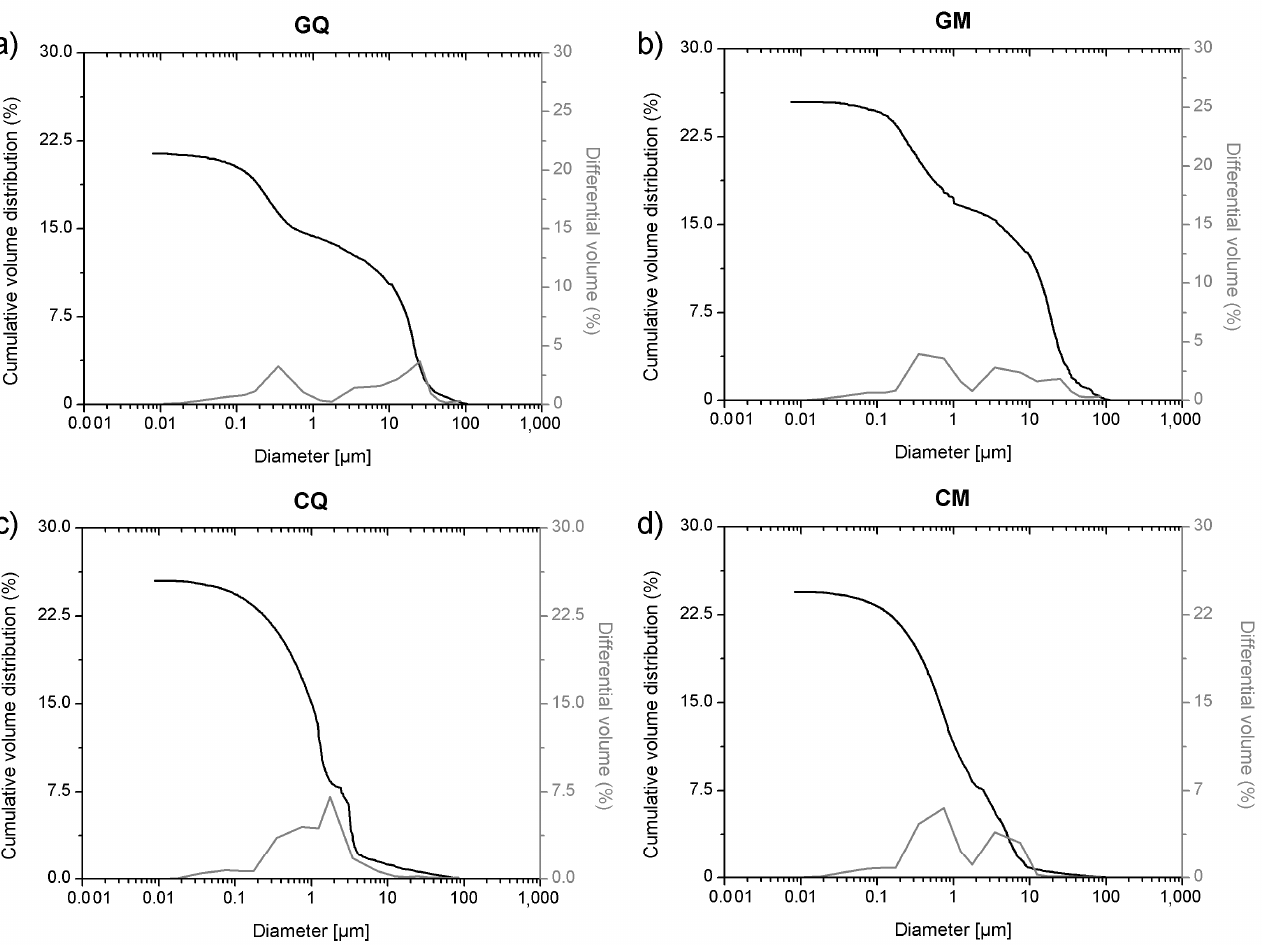
Figure 3. MIP cumulative volume distribution (black) and differential volume (gray) of samples with gypsum (GsQ, left and GsM, right ).